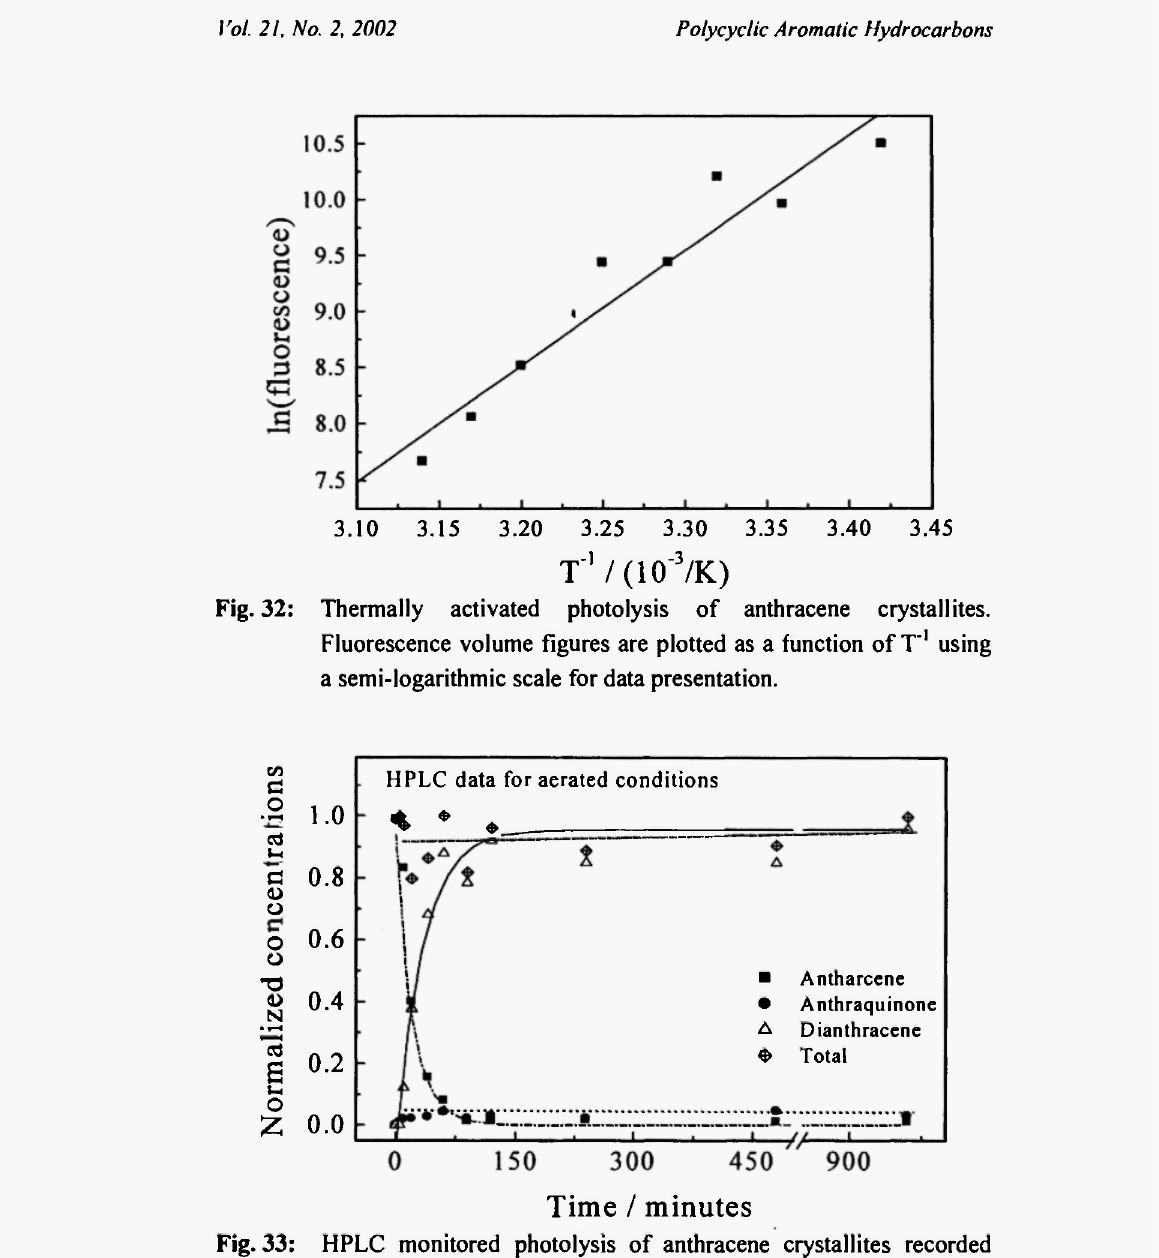
HPLC monitored photolysis of anthracene crystallites recorded under aerated experimental conditions. Relative concentrations (with relation to the initial mass of virgin anthracene) are presented. Observe that the longer the UV-exposure, the lesser the amount of anthracene is left. In turn, the corresponding concentrations of anthraquinone and dianthracene appear to monotonically